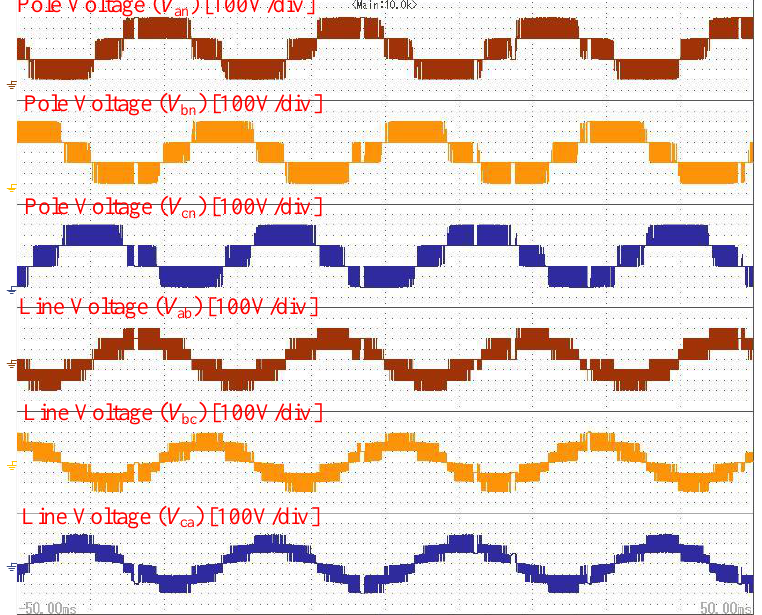
Figure 14. Experimental waveforms show four-level pole voltages and seven-level line voltages.